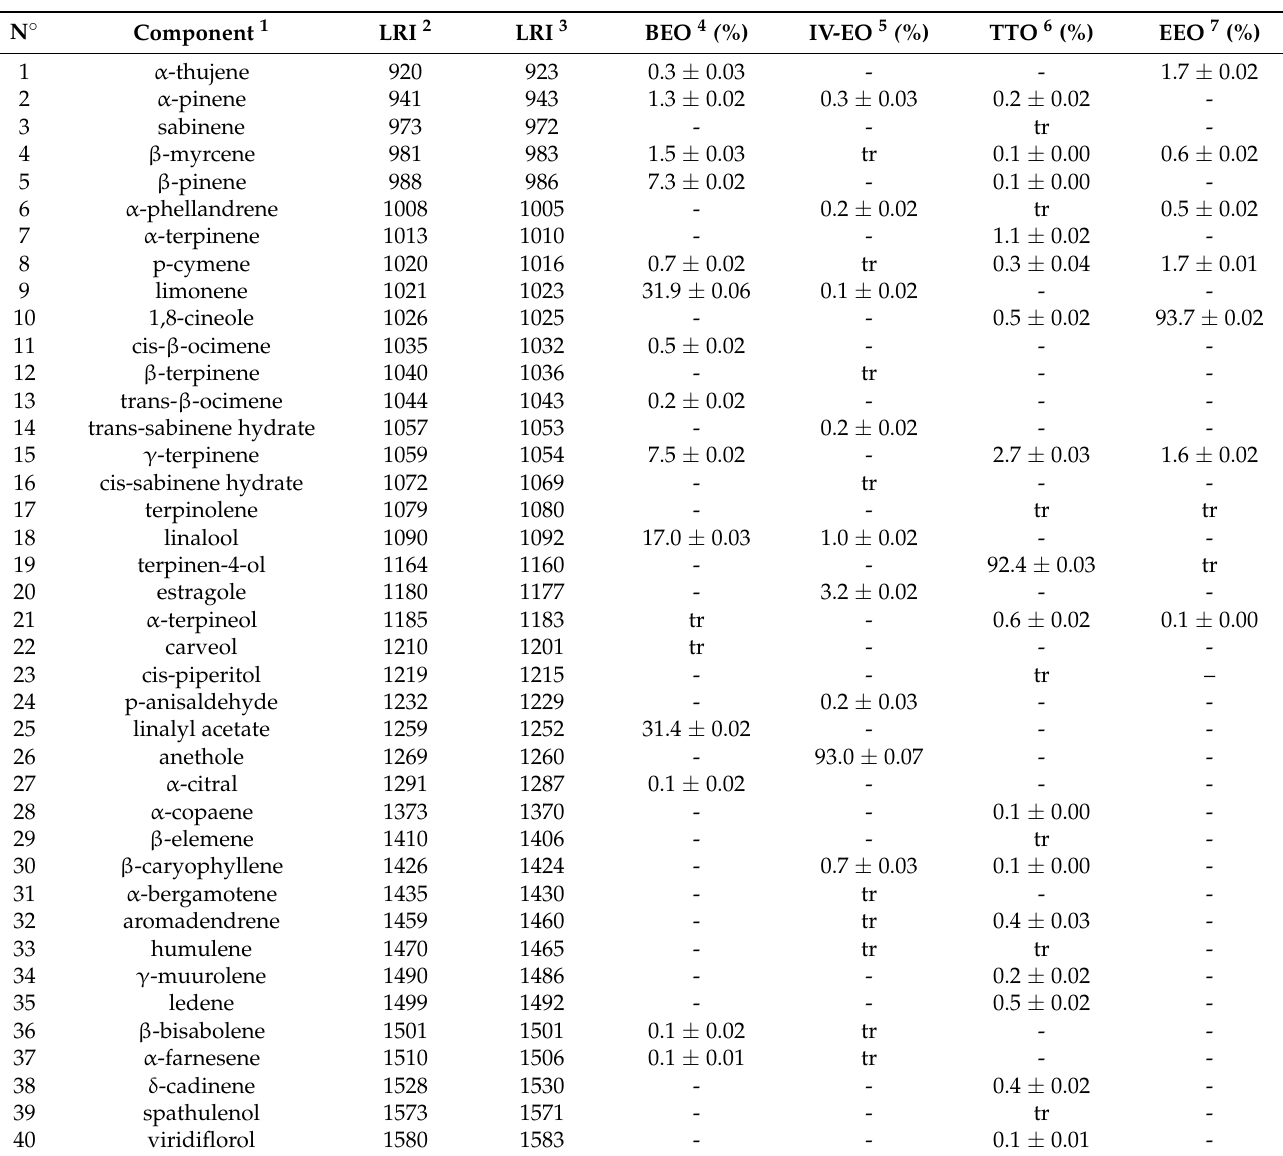
Table 1. Chemical composition (percentage mean value ± standard deviation) of